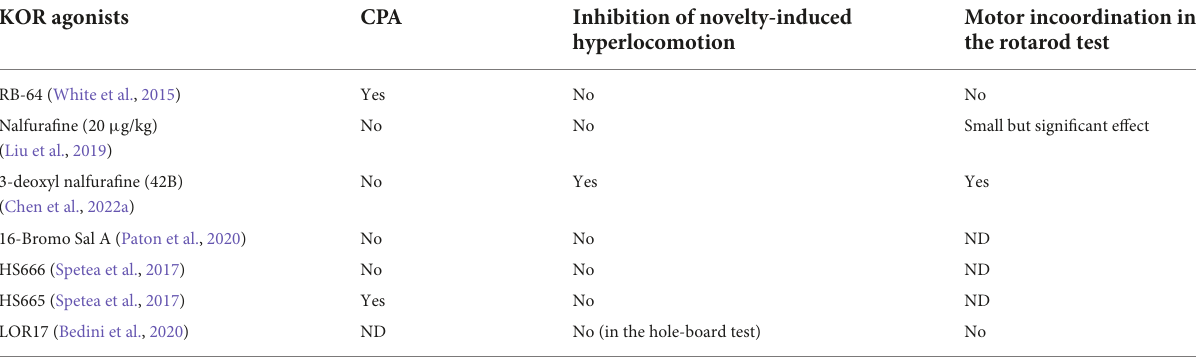
TABLE 6 Effects of KOR agonists on CPA, hypolocomotion and motor incoordination. KOR agonists CPA Inhibition of novelty-induced